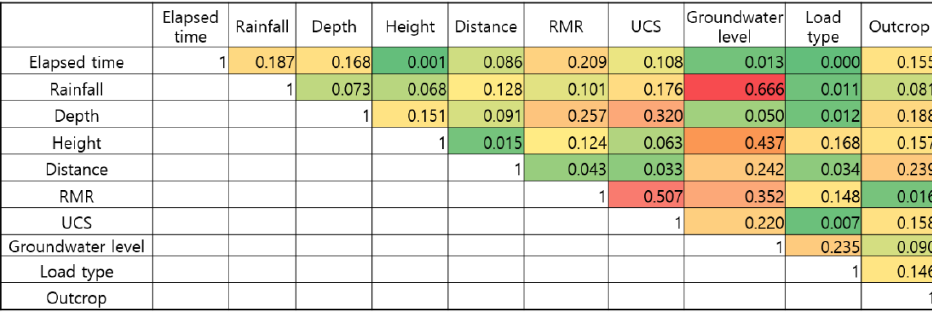
Figure 7. Correlation matrix for checking multicollinearity.